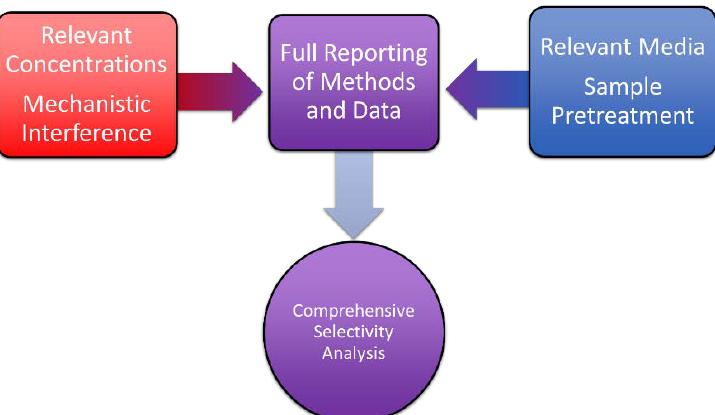
Figure 6. Graphic representation of how interferant experiments that take into account mechanistic interference and concentrations relevant to intended end-use in combination with complex media analysis that takes into account a media type relevant to the intended end-use and minimal sample pre-treatment results in a comprehensive analysis of selectivity for nanofiber sensors.